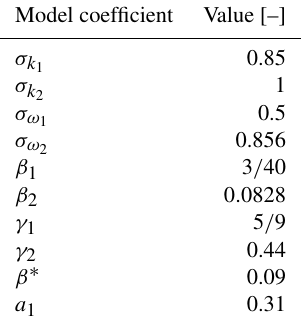
Table 1. Turbulence coefficients for the present k – ω SST model. Model